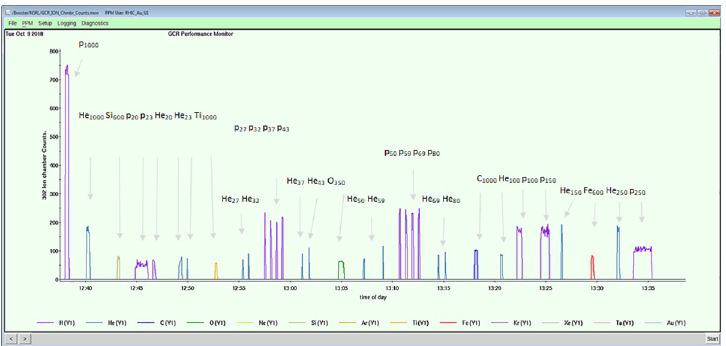
Fig 14. Computer screen shot measuring GCR simulator doses per particle for the 20.8 mGy cycle. GCR, galactic cosmic radiation.